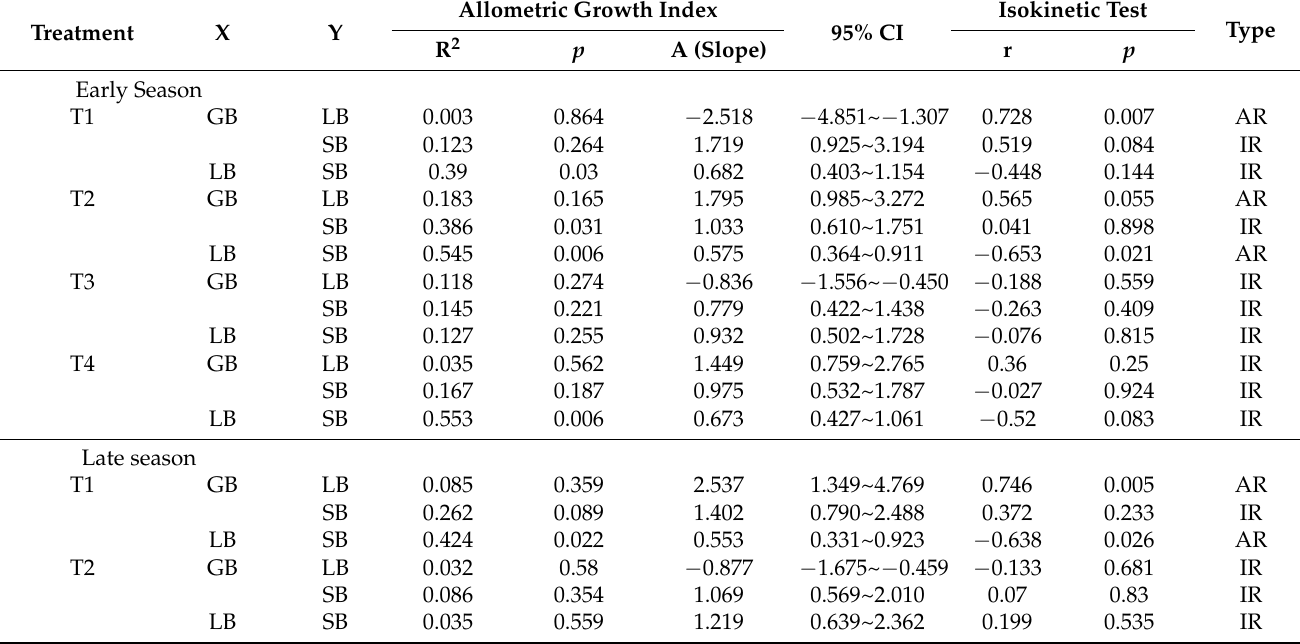
Table 5. Test of allometric growth between organ biomass in early and late season rice.